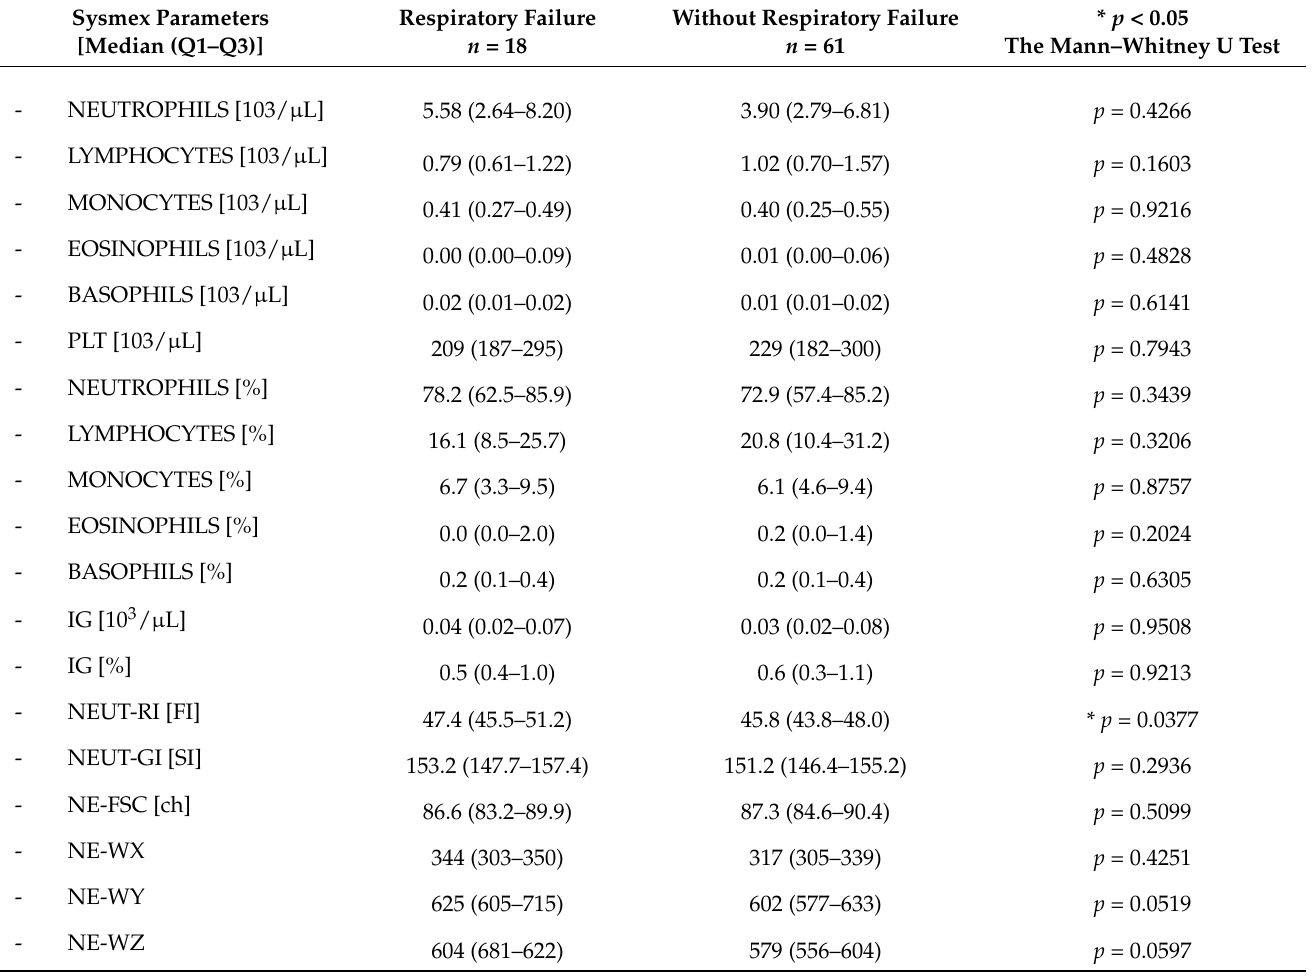
Table 6. Proportion of basic morphological Sysmex parameters and new parameters connected with neutrophils in COVID- 19 patients with respiratory failure and without respiratory failure. Data expressed as median (Q1–Q3)). * indicates p statistically